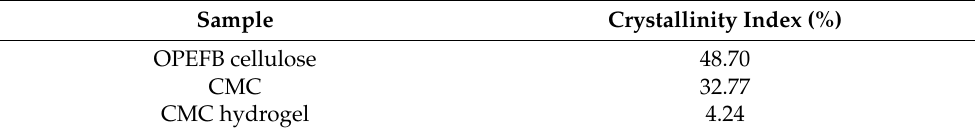
Figure 9. XRD diffractogram of OPEFB cellulose, CMC, and CMC hydrogel. Table 1. Crystallinity index of OPEFB cellulose, CMC, and CMC hydrogel.